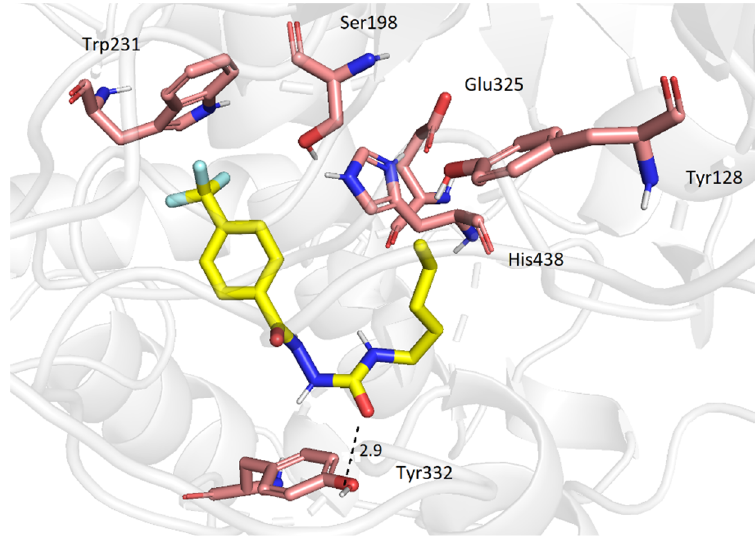
Figure 4. Molecular interactions of 2e (yellow) and BuChE.